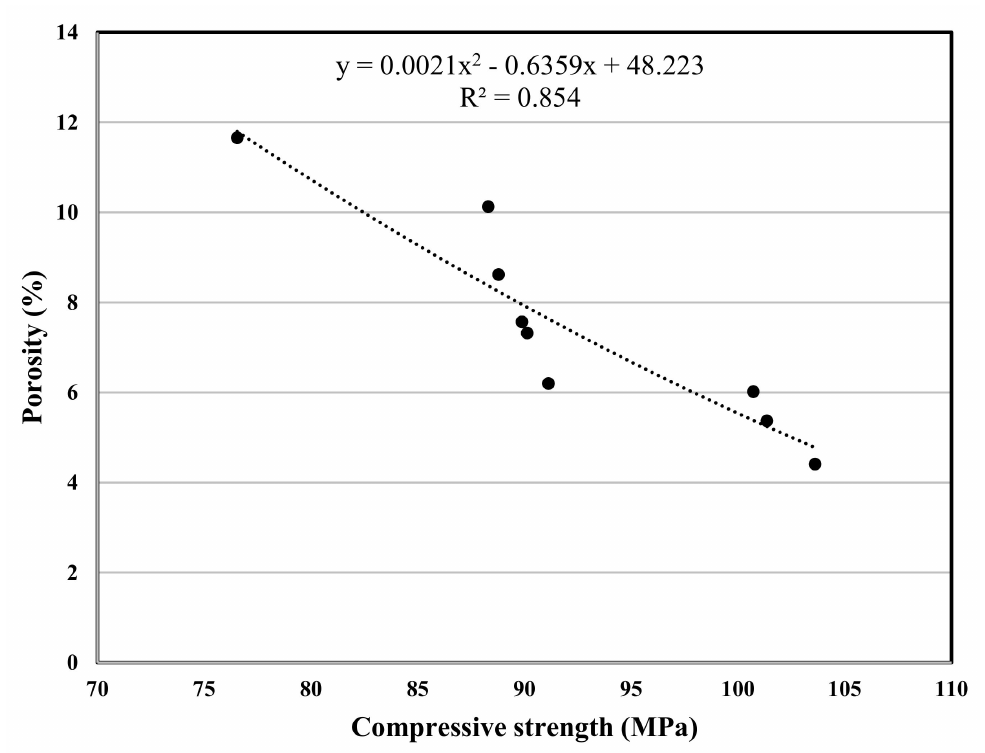
Figure 10. Correlation between compressive strength and